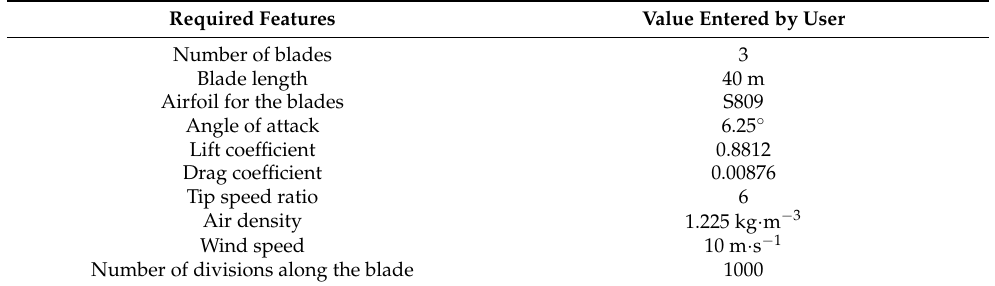
Table 1. Required features of the HAWT rotor, as entered in TTBEM application [44,45]. Required